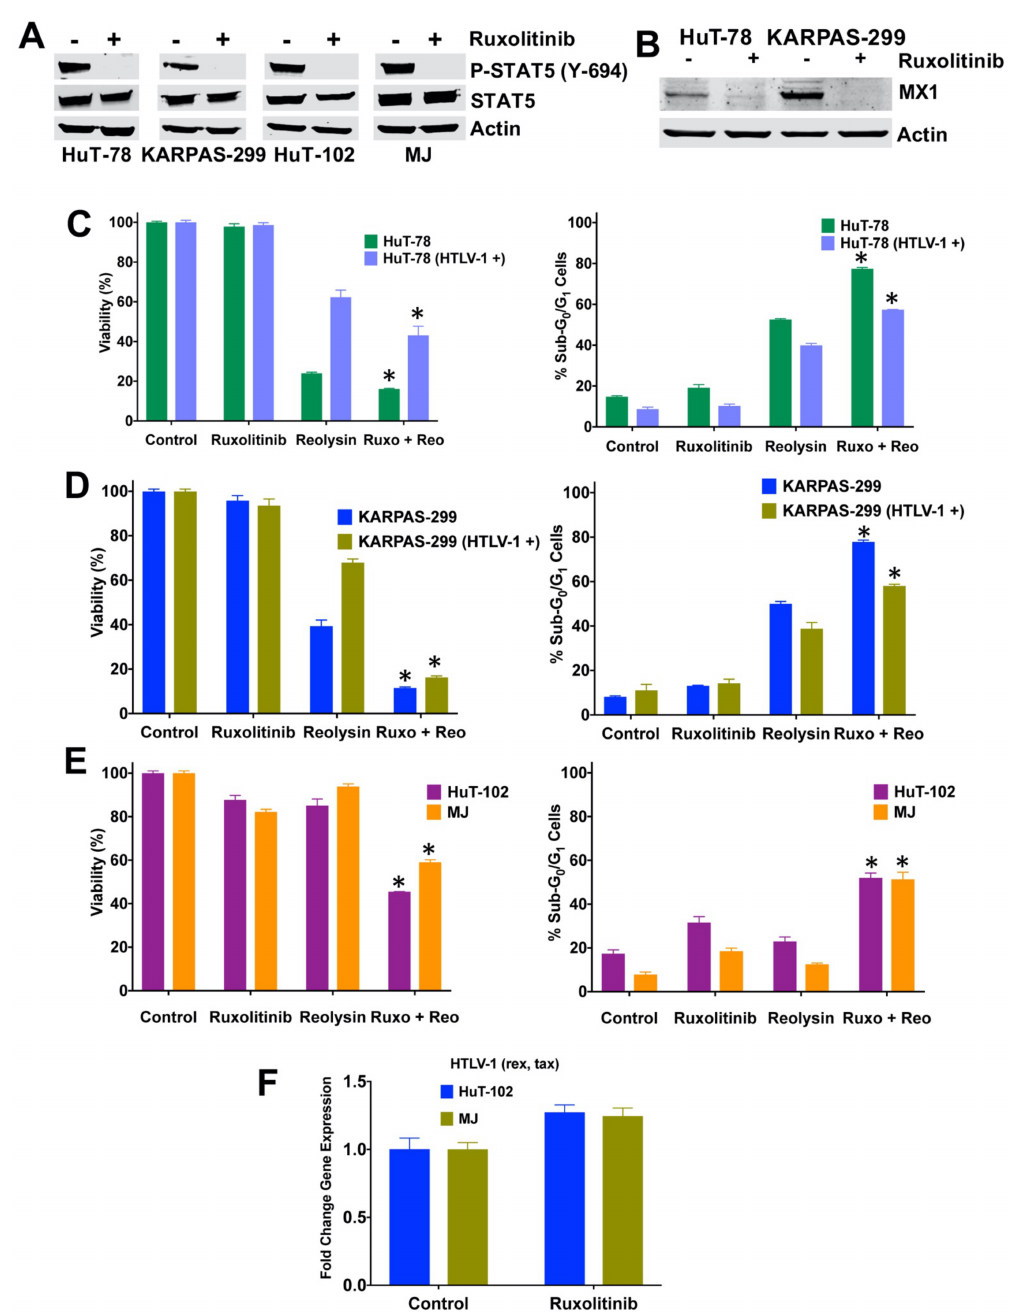
Figure 6. Ruxolitinib enhances the anti-TCL activity of Reolysin in TCL models regardless of HTLV-1 infection status. ( A , B ) Ruxolitinib treatment downregulates the expression of STAT5 phosphorylation and MX1 in TCL cells. TCL cell lines were treated with 10 µ M ruxolitinib for 24 h and protein expression was measured by immunoblotting. ( C , D ) Ruxolitinib augments the efficacy of Reolysin in both the presence and absence of HTLV-1. HuT-78 and KARPAS-299 cells were treated with 10 µ M ruxolitinib, 90 PFU/cell Reolysin (HuT-78) or 45 PFU/cell (KARPAS-299) and the combination for 72 h. Cell viability and apoptosis were assessed by MTT and PI-FACS assay, respectively. ( E ) Ruxolitinib augments the anti-TCL activity of Reolysin in HuT-102 and MJ cells. Cells were treated with 20 µ M ruxolitinib, 1350 PFU/cell Reolysin and the combination for 72 h. Cell viability and apoptosis were assessed by MTT assay. For PI-FACS analysis, cells were treated with 15 µ M ruxolitinib, 1350 PFU/cell Reolysin and the combination for 72 h. Mean ± SD, n = 3. * Indicates a significant difference between the combination and either monotherapy. ( F ) Effects of ruxolitinib on HTLV-1 expression. HTLV-1-positive TCL cells were treated with 20 µ M ruxolitinib for 48 h. HTLV-1 (rex, tax) levels were measured by qRT-PCR. Mean ± SD, n =